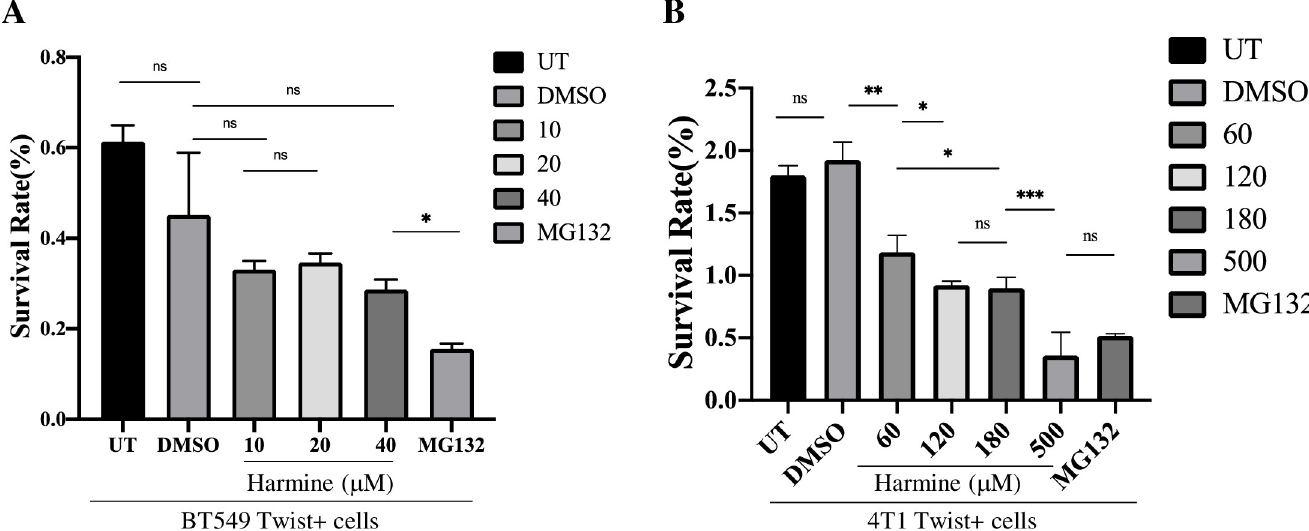
Fig 3. Harmine does not affect the viability BT549 cells, but inhibits the proliferation of 4T1 cells to some extent at the concentrations used in migration and invasion assays. The viabilities of breast cancer cells treated with harmine at concentrations corresponding to those used in wound healing and invasion assays were analyzed (see Materials and Methods). A, Harmine does not affect the viability of BT549 Twist+ cells significantly at concentrations up to 40 μ M. UT represents untreated cells, DMSO indicates a solvent control, and proteasome inhibitor MG132 was used as a positive control. B, 4T1 Twist+ cells were treated with harmine at concentrations of 60, 120 and 180 μ M. UT represents untreated cells, DMSO indicates a solvent control, and proteasome inhibitor MG132 and harmine at 500 μ M were used as positive controls. All data summarize results from four independent experiments. Definitions of statistical significance are � p < .05, �� p < .01, ��� p < .001, and ���� p <